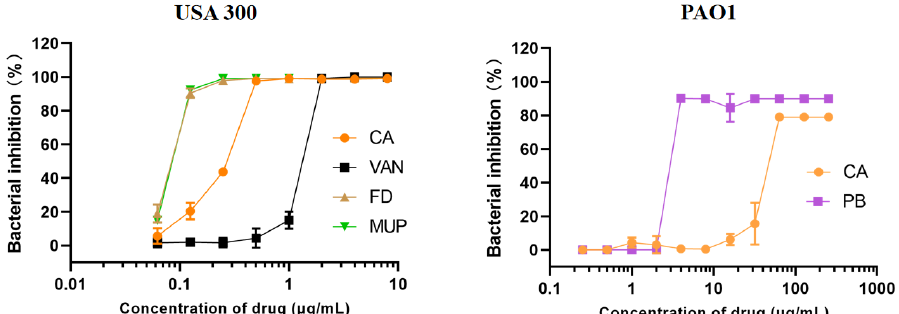
Figure 4. In vitro antibacterial activity of free chrysomycin A against MRSA USA 300 and Pseudomonas aeruginosa PAO1. CA, MUP and FD were dissolved in DMSO, respectively. VAN and PB were dissolved in pure water. The MIC was determined to be the dose of antibiotic that inhibited bacterial growth by >95%. CA has a good inhibitory effect on Gram-positive bacteria Staphylococcus aureus USA300, while displaying poor activity against Gram-negative bacteria Pseudomonas aeruginosa PAO1.